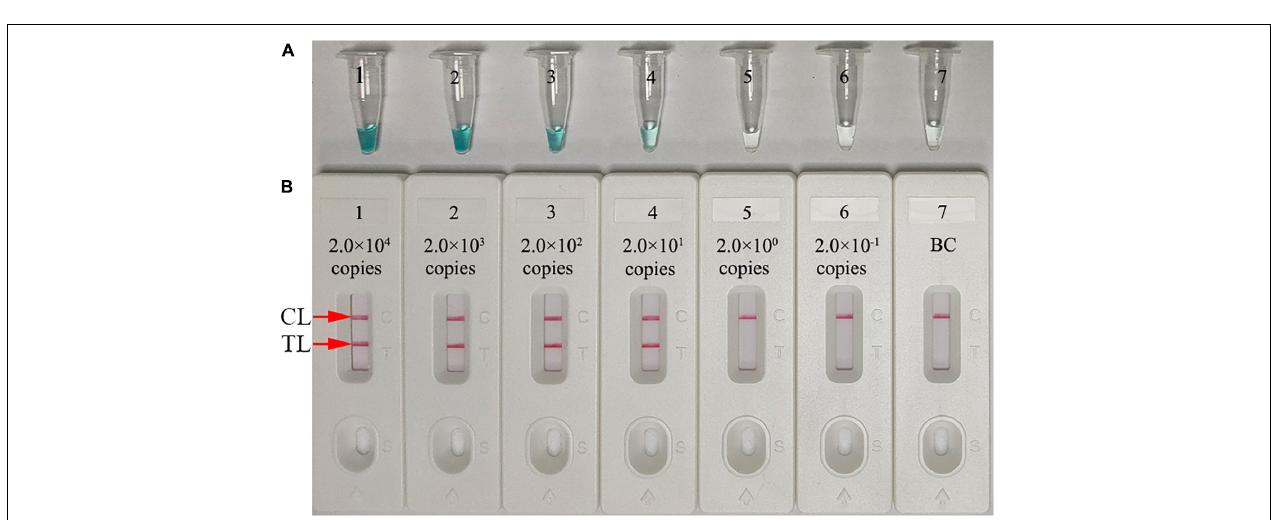
FIGURE 5 | Assay sensitivity using diluted genomic DNA templates. Malachite green (MG) (A) and gold nanoparticle-based LFB (B) techniques were simultaneously used for reporting N. gonorrhoeae- MCDA results. Tubes A1–A7 (Biosensors B1–B7) contained 2.0 × 10 4 , 2.0 × 10 3 , 2.0 × 10 2 , 2.0 × 10 1 , 2.0 × 10 0 , and 2.0 × 10 − 1 DNA copies/reaction and blank control (distilled water). The limit of detection (LoD) of the N. gonorrhoeae- MCDA-LFB assay for orf1 was 2.0 × 10 1 DNA copies/reaction. CL, control line; TL, test